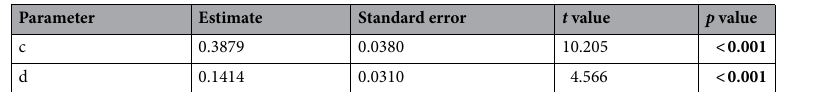
Table 2. Parameter estimates from the power function by least squares method on the relationship of duration and bias (estimated species richness of eBird vs. average observed species richness of BBS). The power function is depicted in Eq. (6) with parameters (c and d) to be estimated. Residual standard error 0.4621 on 562 degrees of freedom. Significant parameters are shown in bold.